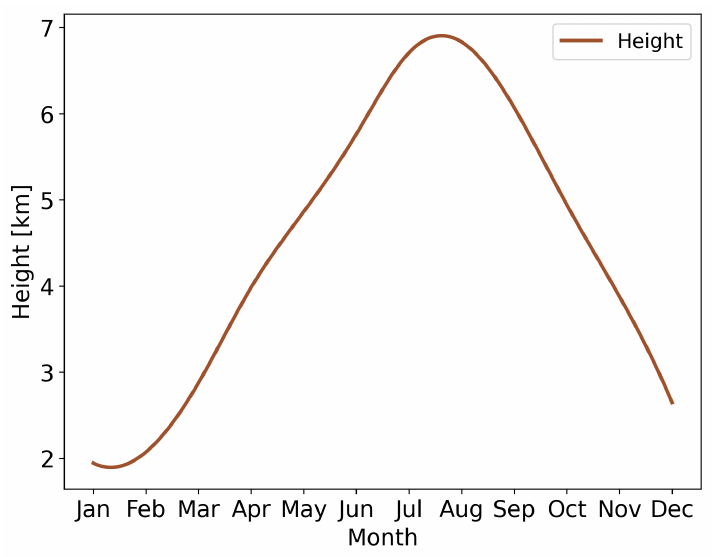
Figure 10. Monthly − 10 ◦ C isotherm height distribution at the Wajima Meteorological